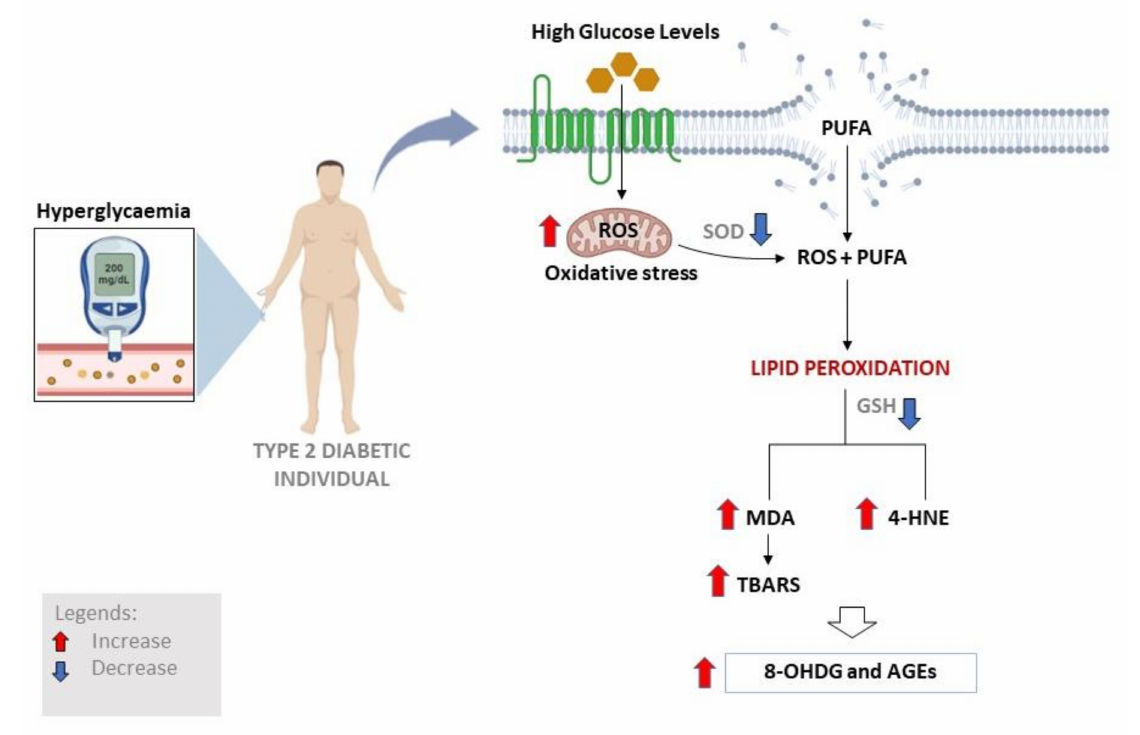
Figure 2. A general overview of the prominent mechanisms and makers of lipid peroxidation such as MDA, 4-HNE, TBARS, that are implicated in type 2 diabetes-related complications. Abbreviations; PUFA: polyunsaturated fatty acid; ROS: reactive oxygen species; SOD: superoxide dismutase;